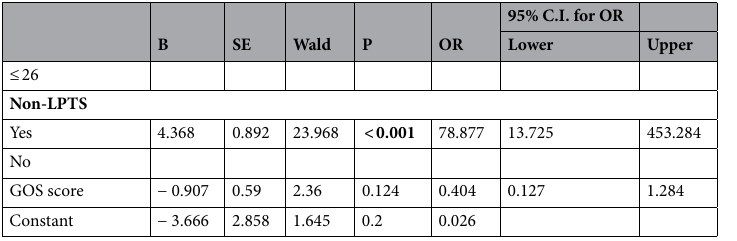
Table 3. Multivariate analysis. As can be seen from the above table, Site, Chronic alcohol use, Volume, Fracture, SDH, GCS score, and Non-LPTS can significantly affect PTE ( P < 0.05). SDH subdural hematoma, SAH subarachnoid hemorrhage, TVS third ventricle status, GCS glasgow coma scale, ICP intracranial pressure, C-G/L cerebrospinal fluid glucose/cerebrospinal fluid lactate ratio, ICI intracranial infections, LPTS late post- traumatic seizure, COS glasgow outcome scale. Significant values are in bold.